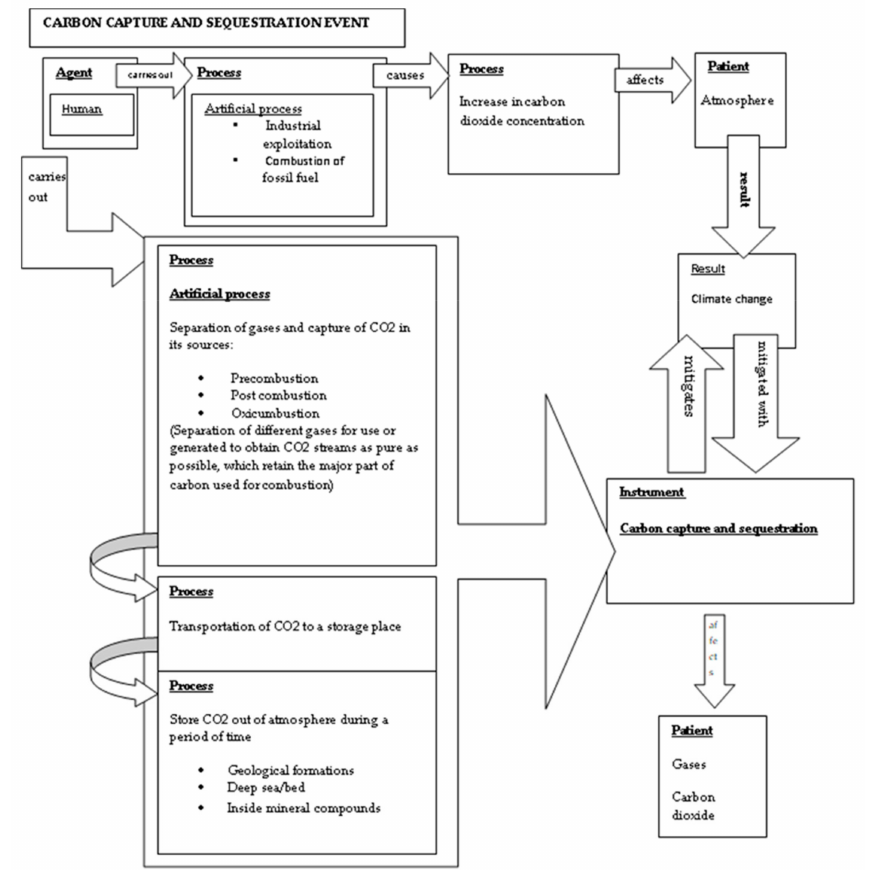
Figure 3. The CARBON CAPTURE AND SEQUESTRATION